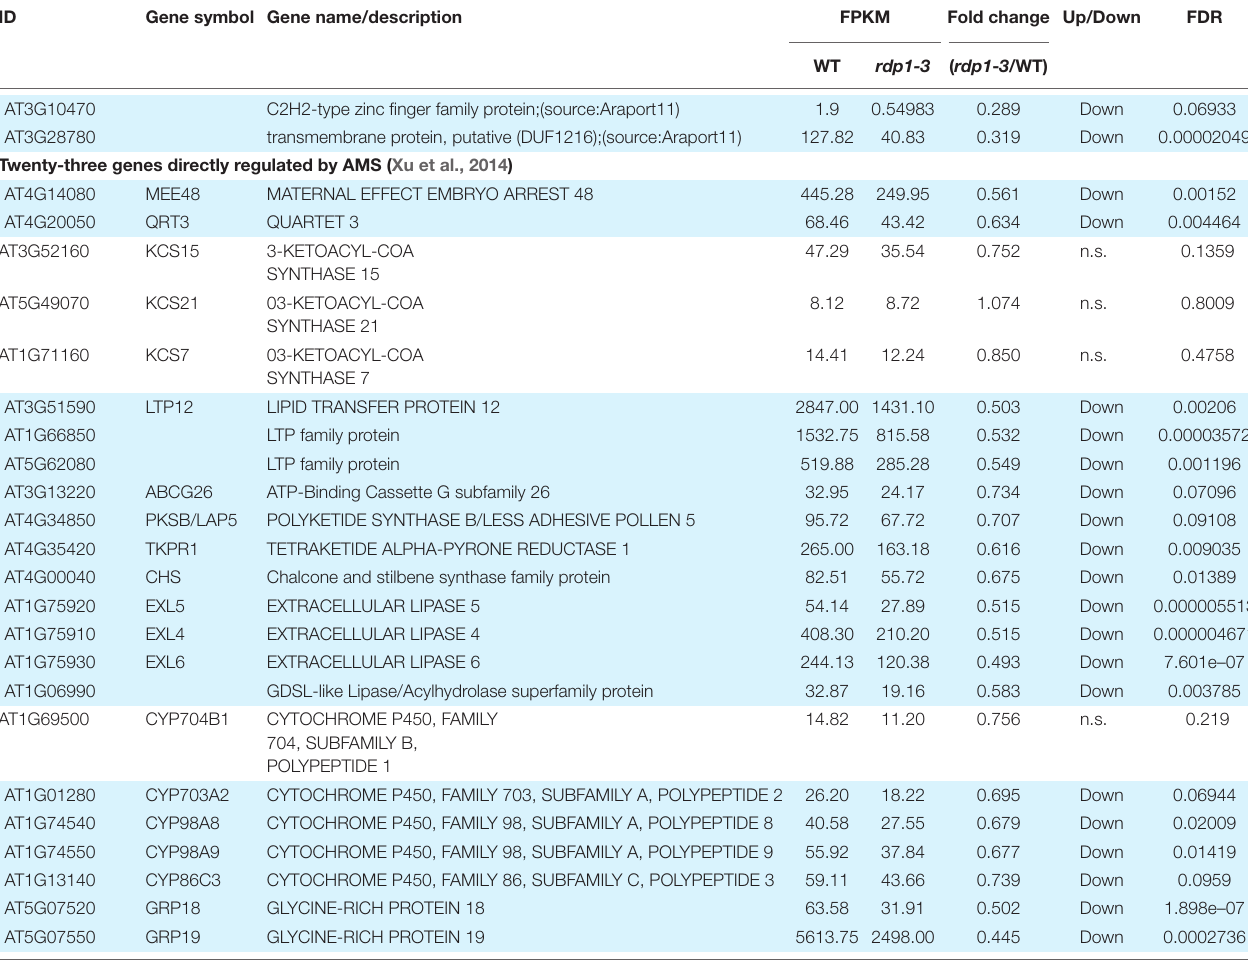
The genes highlighted in blue are